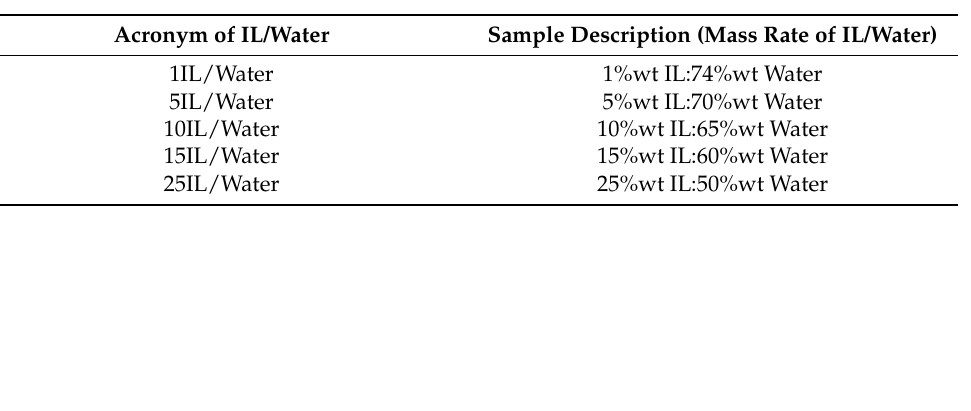
Table 1. The acronym that describes the generated Il/water emulsions under study with 1-ethyl-3- methylpyridinium perfluorobutanesulfonate named as